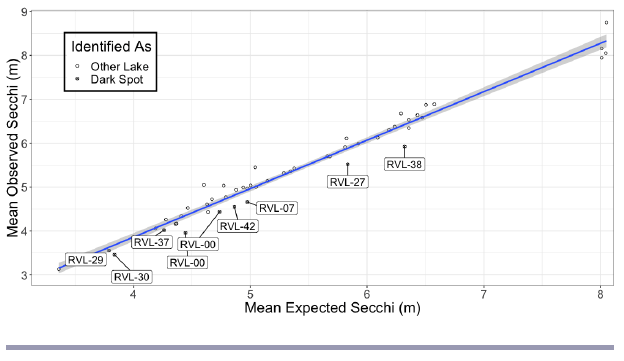
Fig. 4 . Eight bright spot sites (of 53) on seven lakes (of 39) and nine dark spot sites on eight lakes designated from model results.